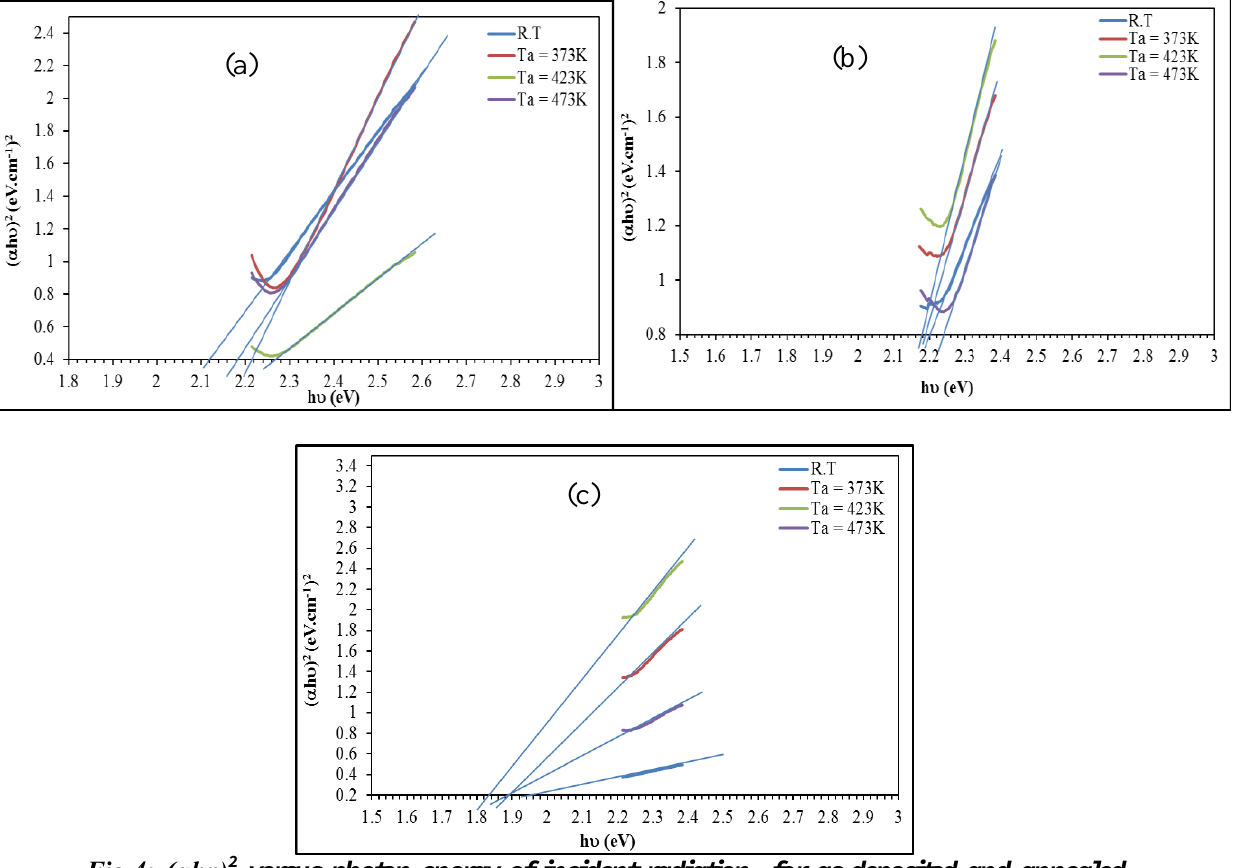
Fig.4: (αhʋ) 2 versus photon energy of incident radiation for as-deposited and annealed thin films (B-band) of NiPc/C blends with three different ratios of C 60 (b) (100/10), and (c)